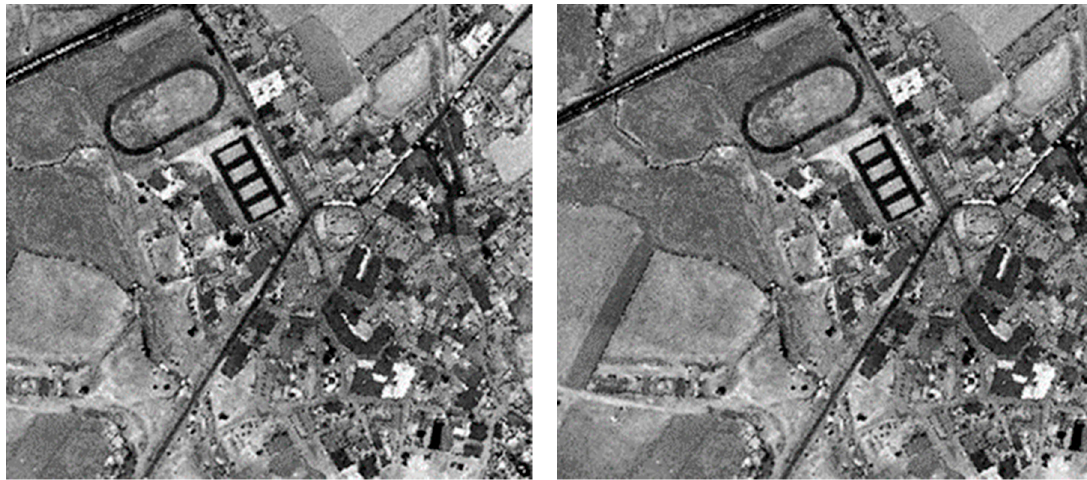
Figure 7. Synthetic model of intensity generated and densified for a LiDAR point cloud.